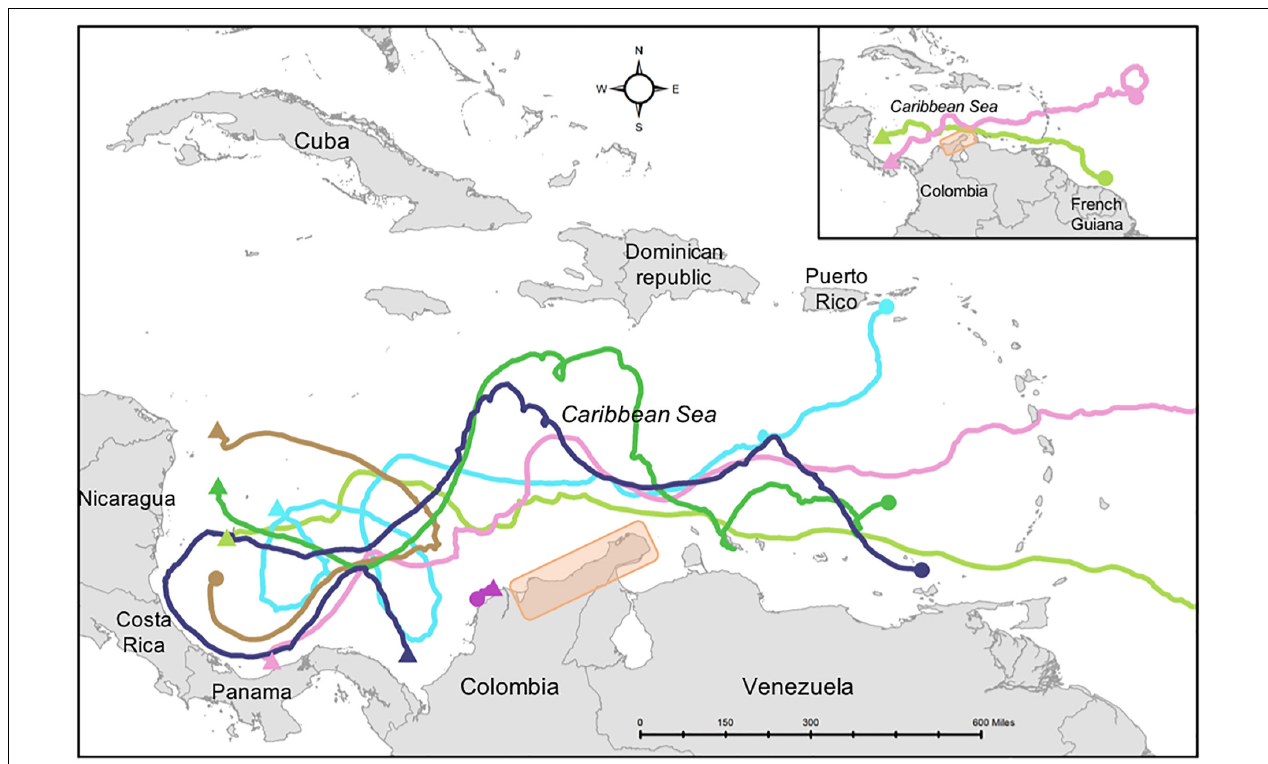
FIGURE 6 | Trajectories of selected ocean surface drifters in Southern Caribbean (color curve lines) and western Atlantic Ocean (pink and light green curve lines). The figure exemplifies the feasibility of drifters released at different point locations (color dots) in the Atlantic Ocean to pass by the study area in northeastern Colombia (orange rectangle). Arrow tips represent direction of the